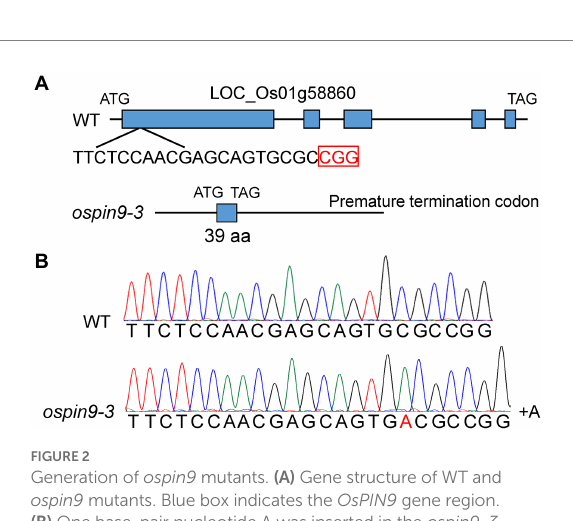
FIGURE 2 Generation of ospin9 mutants. (A) Gene structure of WT and ospin9 mutants. Blue box indicates the OsPIN9 gene region. (B) One base-pair nucleotide A was inserted in the ospin9-3